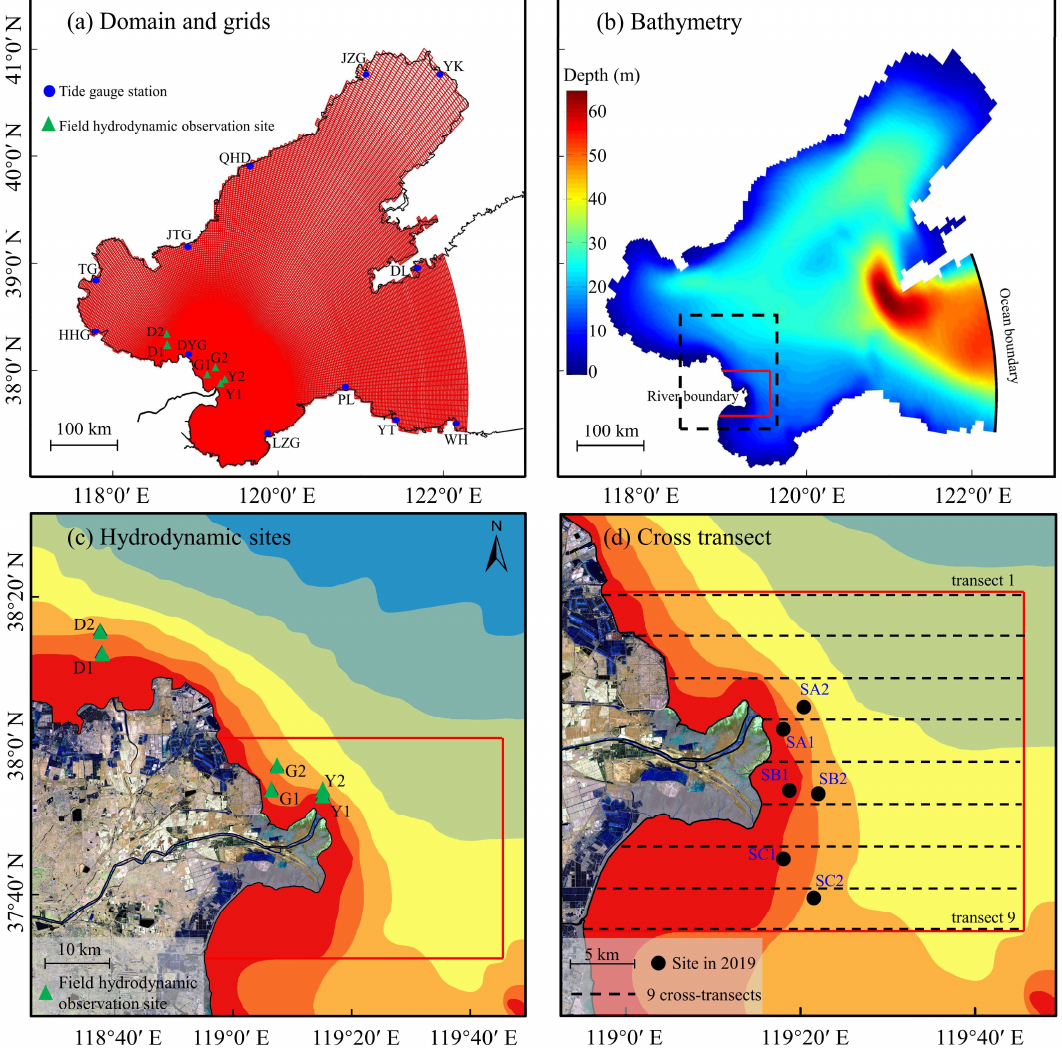
Figure 2. ( a ) Computational domain and mesh, locations of the tide gauge stations (blue points) and hydrodynamic observation sites (green triangles). ( b ) Topography of the Bohai Sea, the river boundary and the offshore boundary are shown. ( c ) Hydrodynamic observation sites are used for model validations. ( d ) Nine equally spaced cross-sections (black do(cid:308)ed lines) are used for hydrodynamic analysis; the six black dots show observation sites in July 2019.